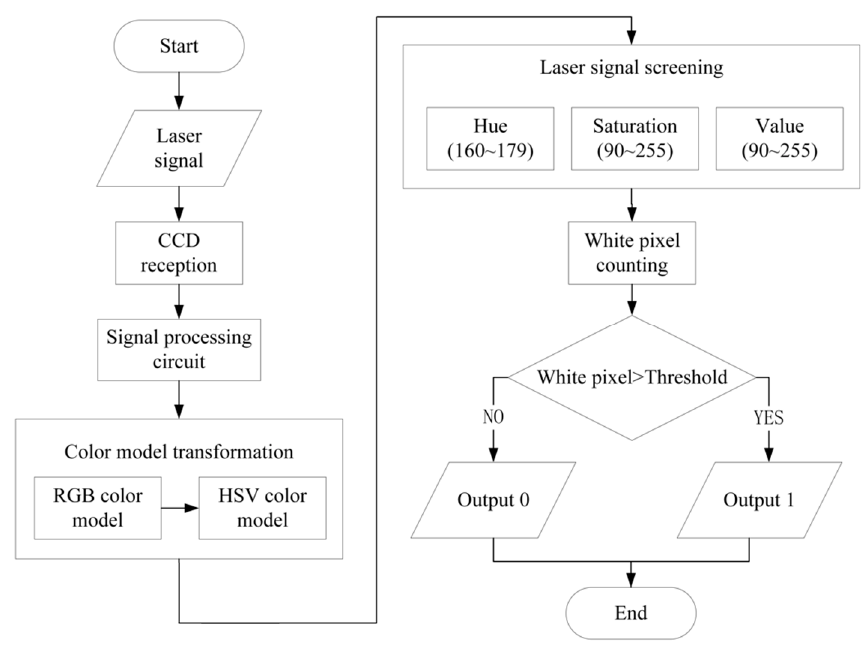
Figure 3. The block diagram of imaging identification and screening process; CCD: Charge-coupled device.